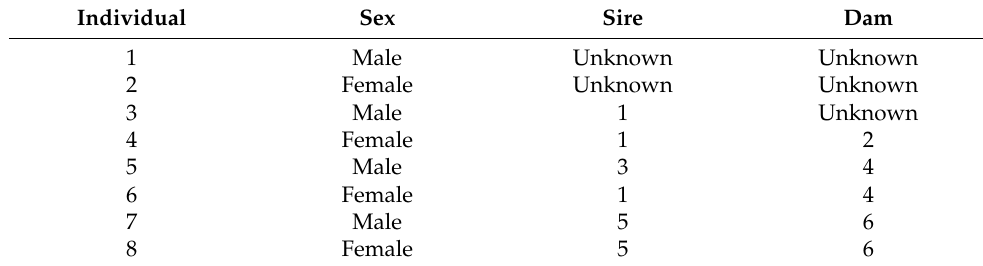
Table 1. Pedigree data from Fernando and Grossman